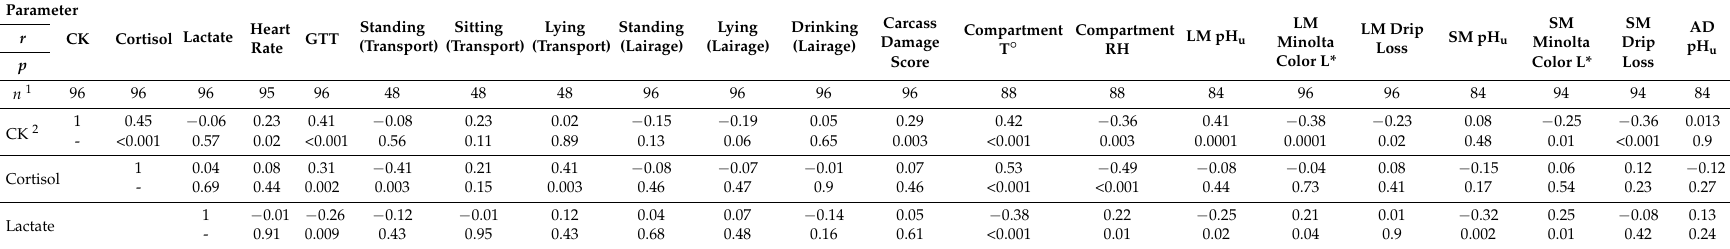
Table 4. Correlations (Pearson, r values) between blood parameters, heart rate, gastrointestinal tract temperature (GTT), trailer temperature (T ◦ ) and relative humidity (RH), transport and lairage behaviors, carcass damage score and meat quality characteristics as assessed in the longissimus (LM), semimembranosus (SM) and adductor (AD)